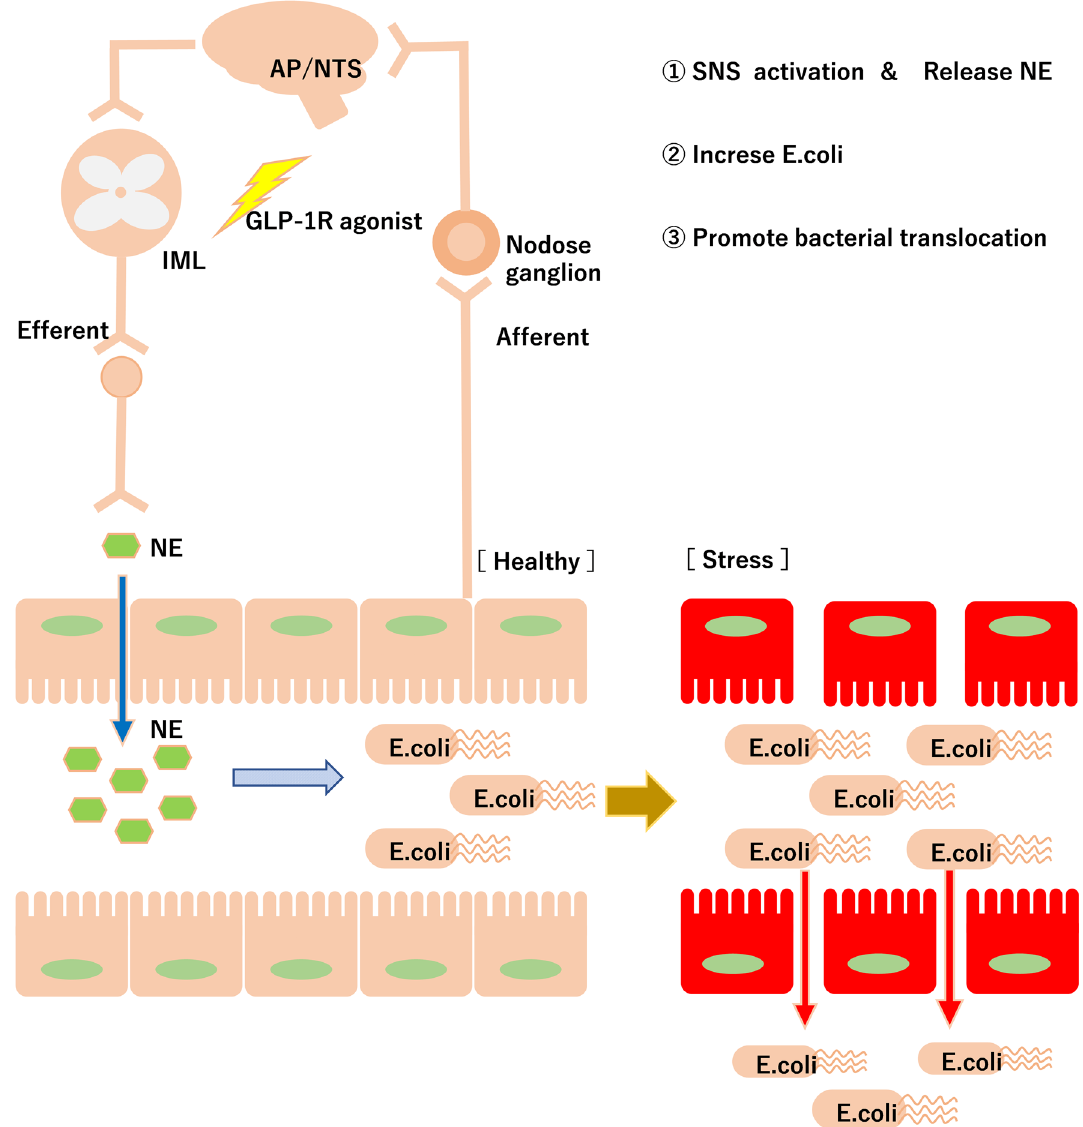
Figure 7. Schematic of this experiment. Acute administration of liraglutide causes these three phenomena: (1) sympathetic nervous system (SNS) activation and release of norepinephrine to the intestinal lumen, (2) increased levels of E. coli in cecal contents, and (3) promotion of bacterial translocation under stress conditions, such as colitis. This image was drawn using Microsoft’s PowerPoint 2016 (www. micro soft.